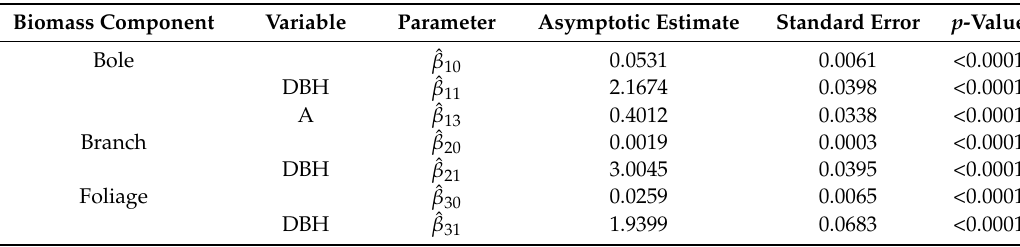
Table 5. Parameter estimates and their asymptotic standard error and p- values for the additive biomass equation system based on diameter at breast height (DBH) and age (A) (Model System III).